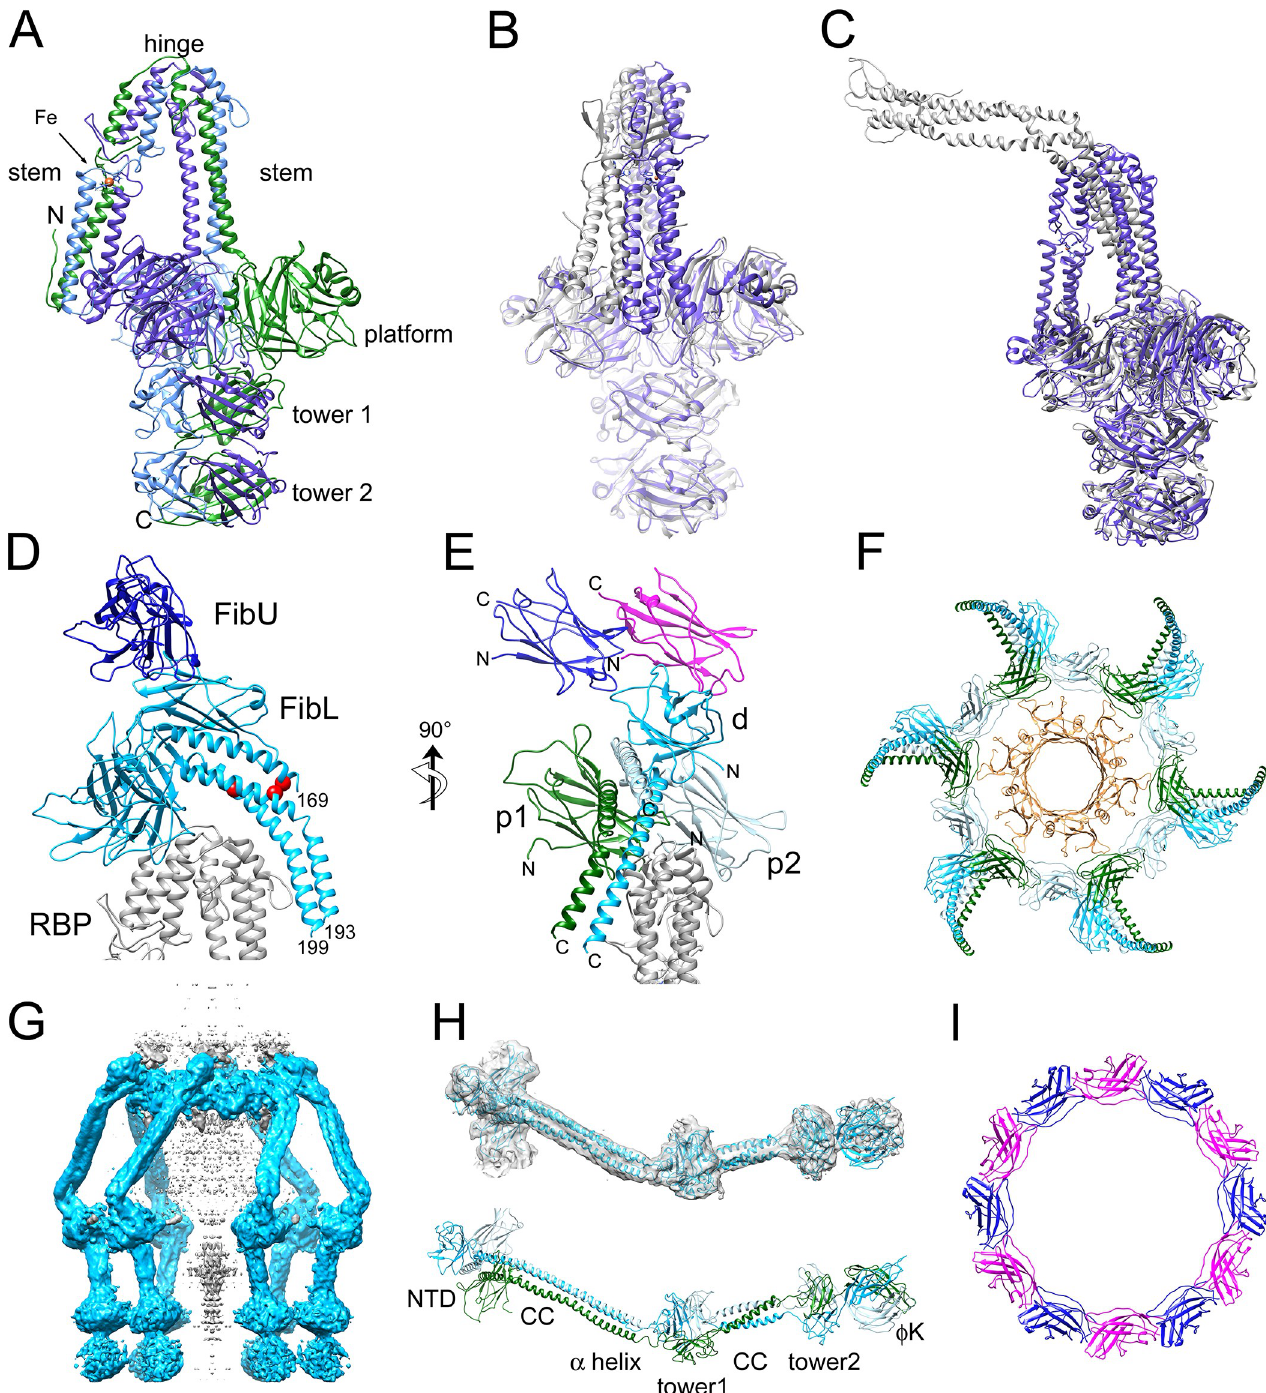
Fig 5. The peripheral structures. (A) Atomic model of the 80 α RBP homotrimer. The three subunits are colored purple, blue and green. The stem, hinge, platform and two tower domains are indicated, as is an Fe atom (orange) coordinated by six His residues in the stem domain. (B) Superposition of 80 α (purple) and ϕ 11 (gray) RBPs, aligned by the tower and platform domains and rotated to emphasize the differing orientations of the stem domains. (C) Superposition of 80 α RBP (purple) with the tail fiber (gp17) of P68 (gray), aligned by the tower domains. (D) Ribbon representation showing FibL (light blue), FibU (dark blue) and part of the RBP stem (gray). The positions of the K169 residues in the three FibL subunits are shown as red balls to indicate the relative shift of the three α - helices in the coiled coil. The C-terminal residue modeled in each FibL subunit is numbered. (E) Rotated view of D with the three FibL subunits colored green (p1), pale blue (p2) and blue (d). The two FibU subunits are in dark blue and magenta. RBP is gray. (F) Top view of baseplate showing the FibL